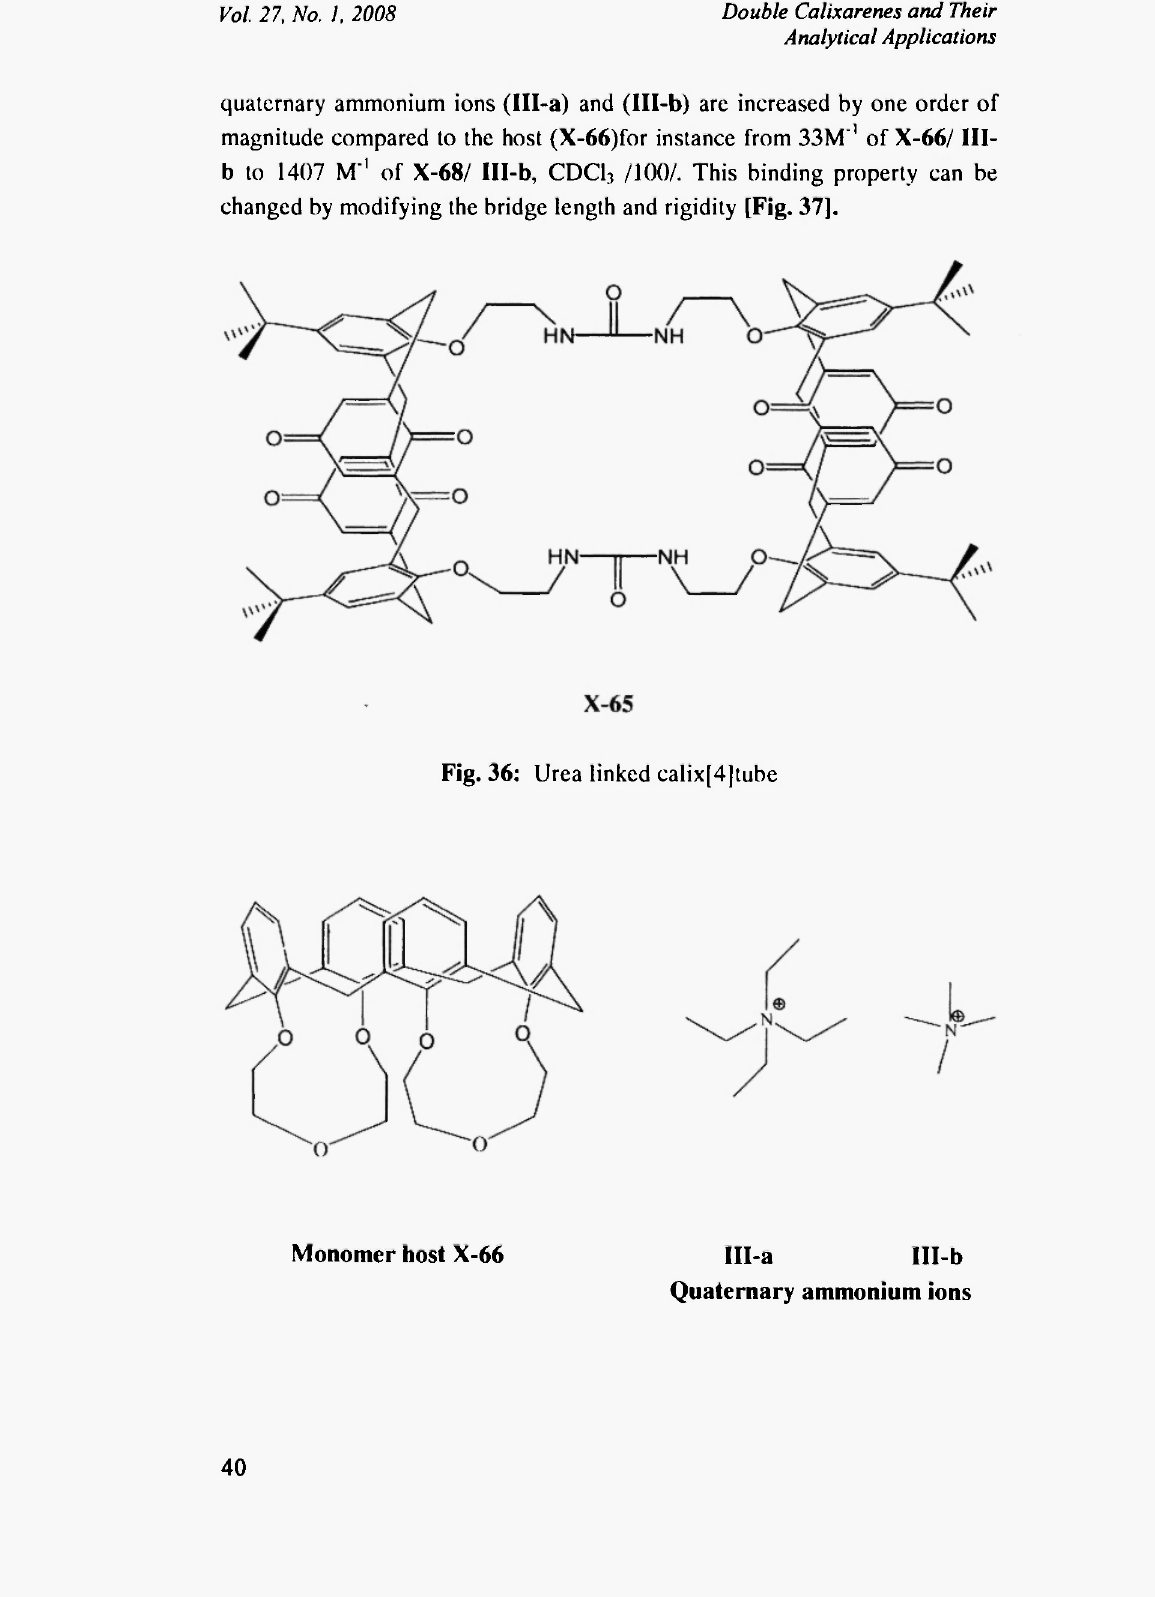
Fig. 36: Urea linked